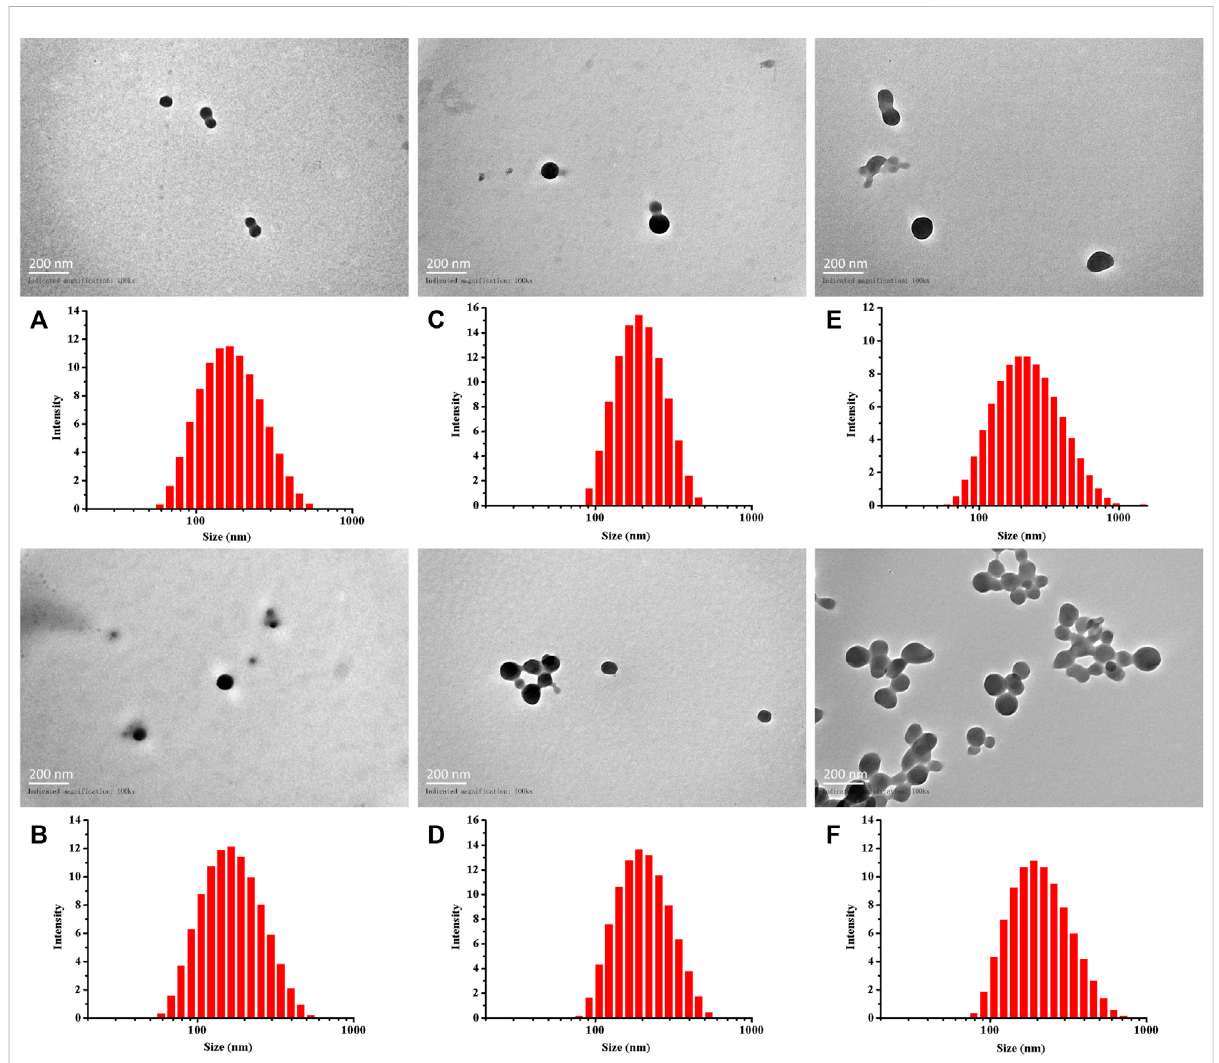
FIGURE 1 Size distribution and TEM images of (A,C,E) Cy5-labeled Oxi- α CD NPs and (B,D,F) Cy5-labeled FA-Oxi- α CD NPs: (A,B) 150 – 160 nm, (C,D) 180 – 190 nm, and (E,F) > 220